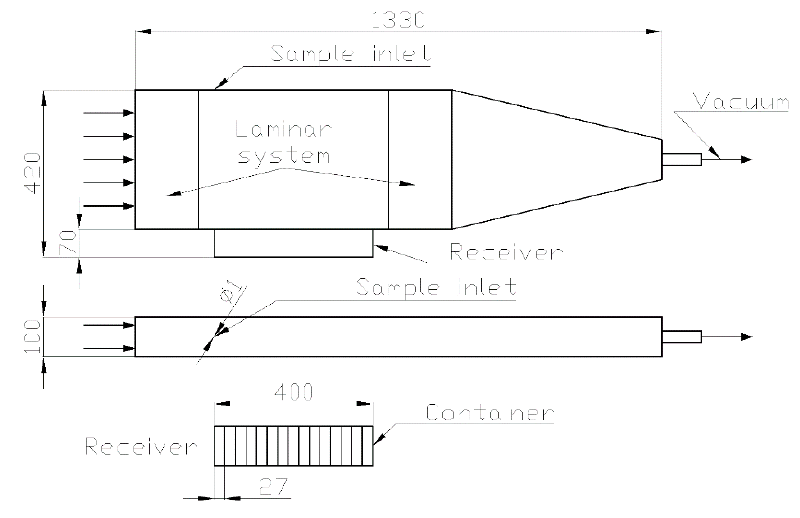
Figure 2. Pneumatic separator outline.